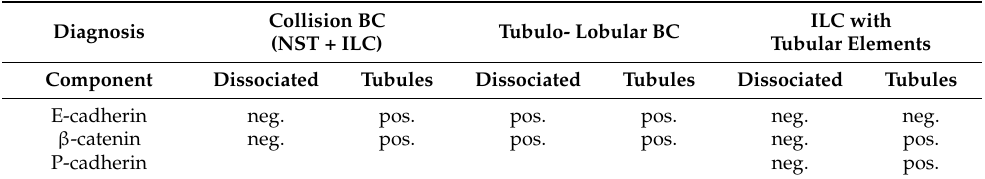
Table A5. Suggested IHC work-up for the differential diagnosis in BCs with mixed-appearing morphology (modified according ref.